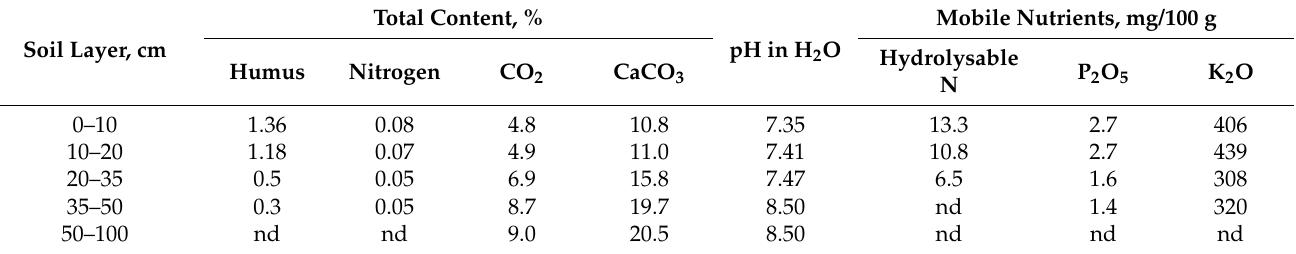
Table 2. Main agrochemical properties of the experimental field soil (2019).